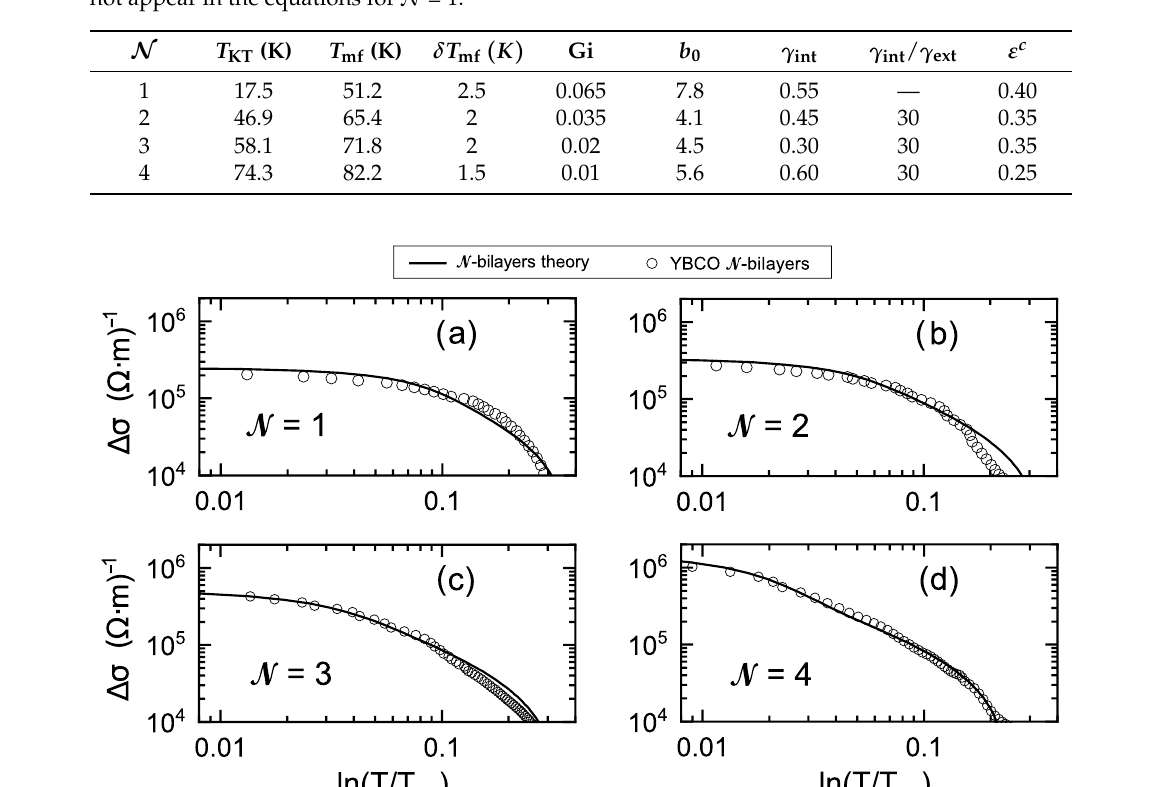
Table 1. Parameter values resulting from the fits represented in Figures 2 and 3. Note that γ ext does not appear in the equations for N = 1.